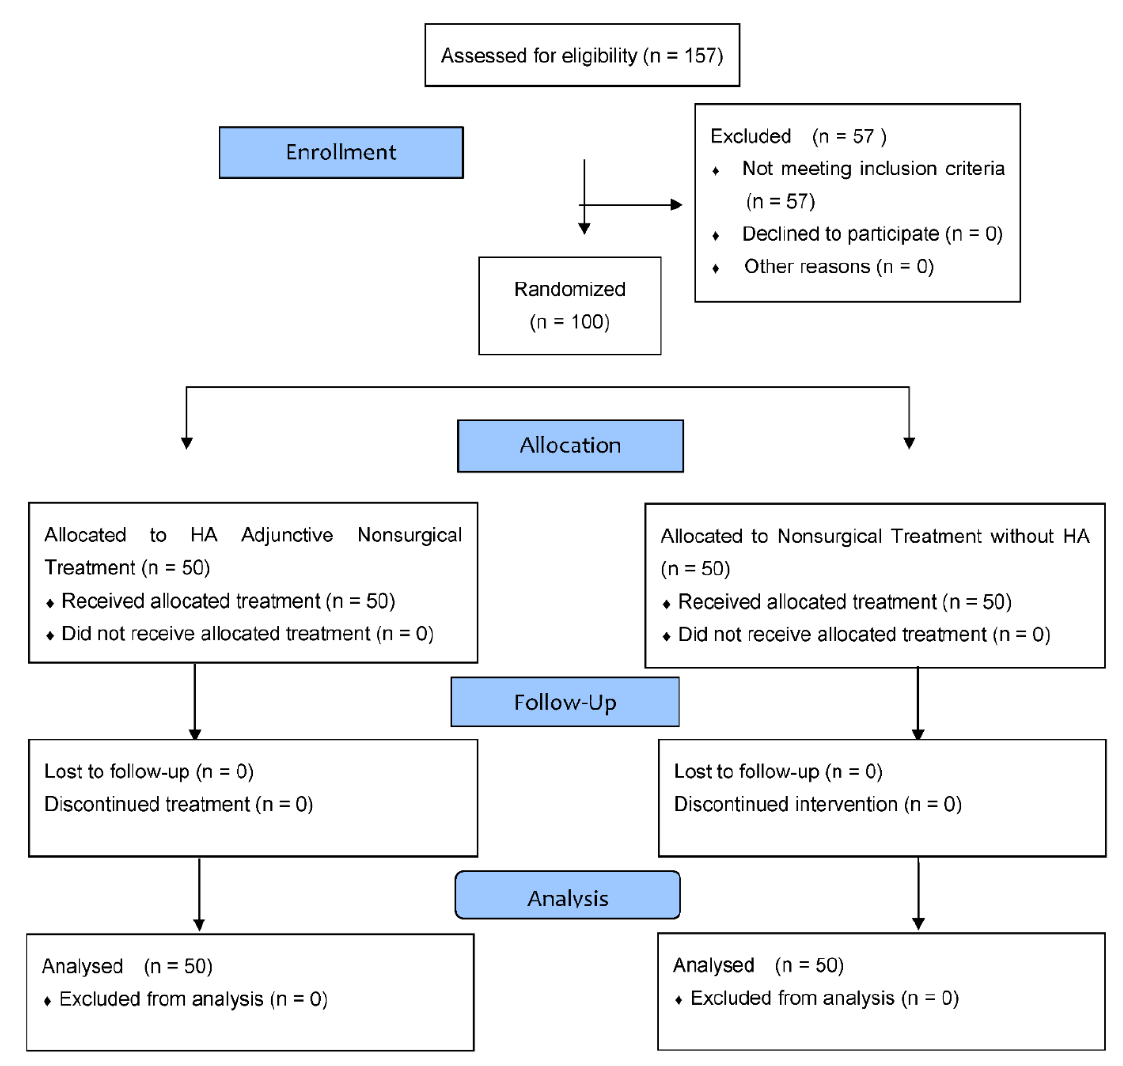
Figure 1. CONSORT 2010 flow diagram.